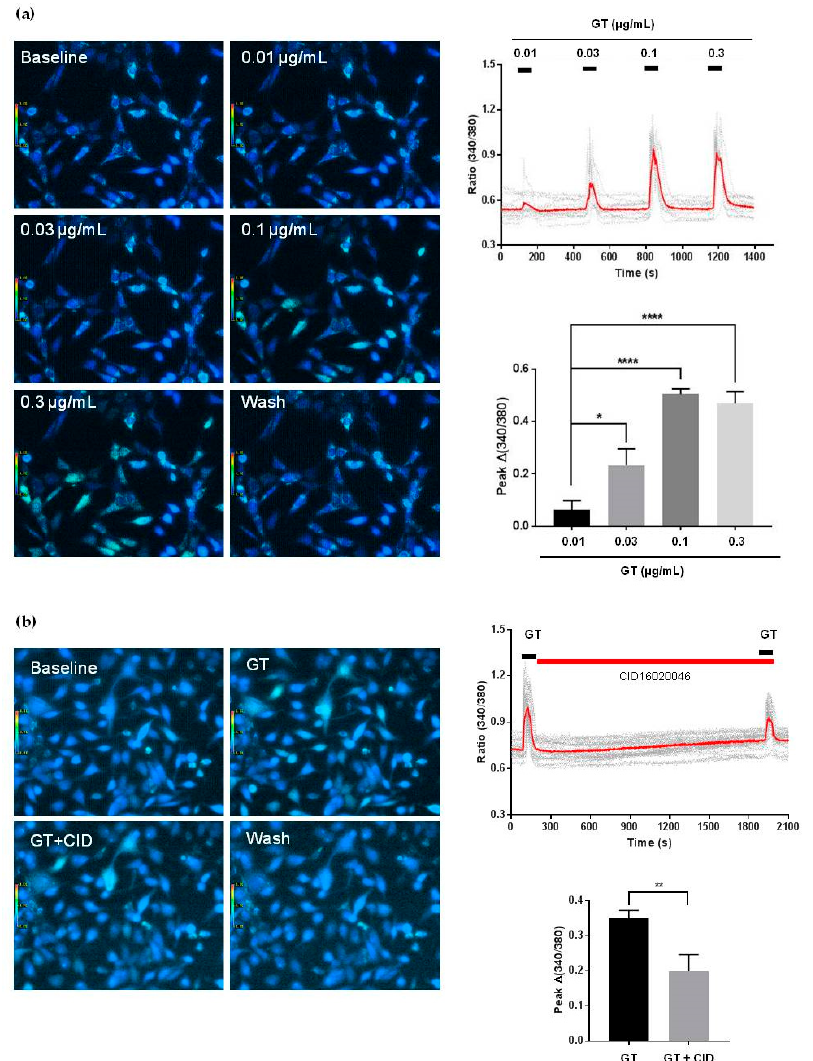
Figure 5. E ff ects of gintonin on transients [Ca 2 + ] i ( a ), and e ff ects of the GPR55 antagonist CID16020046 on gintonin (0.1 µ g / mL)-mediated transients [Ca 2 + ] i ( b ) in PC-3 cells. Analyses of the localization of calcium signals via confocal microscopy were performed with Fura-2 / AM and a nuclear dye. ( a ) Intracellular Ca 2 + levels were determined in PC-3 cells exposed to gintonin (0.01, 0.03, 0.1, and 0.3 µ g / mL). PC-3 cells from each group were incubated for 40–60 min at room temperature with 5 µ M Fura-2 / AM (Thermo Fisher Scientific Korea, Gangnam-gu, Seoul, Korea) and 0.001% Pluronic F-127 (Thermo Fisher Scientific Korea, Gangnam-gu, Seoul, Korea) in a HEPES-bu ff ered solution (pH 7.4). Cells were illuminated using a xenon arc lamp, and excitation wavelengths (340 and 380 nm) were selected using a computer-controlled filter wheel (Sutter Instrument, Novato, CA, USA). Left panel: representative pictures of [Ca 2 + ] i levels in PC-3 cells in the absence or presence of various concentrations of gintonin. Upper right panel: representative [Ca 2 + ] i peaks associated with di ff erent gintonin concentrations. Lower right panel: histograms of the dose-dependent responses to gintonin. ( b ) Left panel: representative pictures of [Ca 2 + ] i levels in PC-3 cells in the absence or presence of CID16020046 (10 µ M). Upper right panel: representative peaks of [Ca 2 + ] i transients in the absence or presence of CID16020046. Lower right panel: histograms of the e ff ects of CID16020046 on gintonin (0.1 µ g / mL)-mediated [Ca 2 + ] I transients. Data were obtained from 45–50 di ff erent cells in three independent experiments. Data represent means ± SD. * p < 0.05, **** p < 0.0001 compared to 0.01 µ g / mL gintonin ( a ); ** p < 0.01, compared to the 2nd GT application ( b